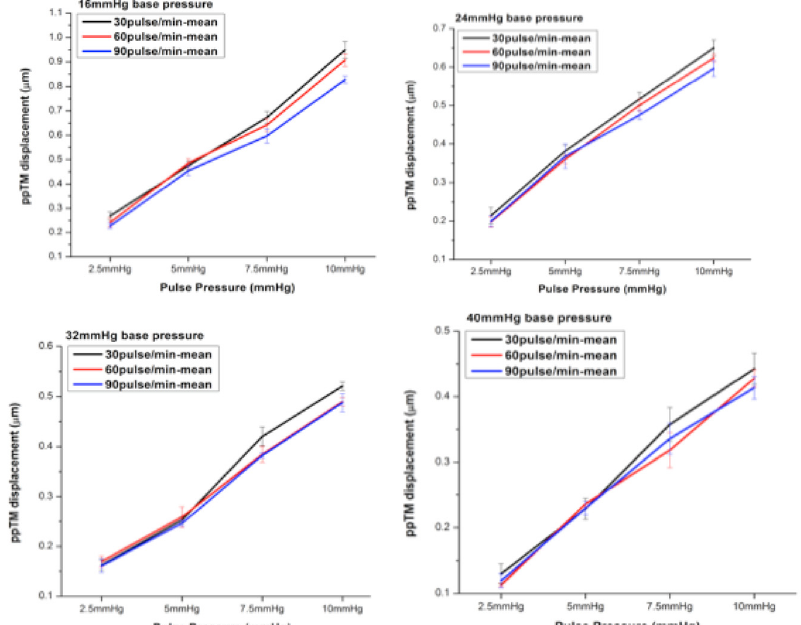
Figure 4. The mean and standard deviation of the peak-to-peak trabecular meshwork displacement (ppTMD) from applying various mean pressures, pulse amplitudes, and pulse frequencies. A different color specifies each pulse frequency, and each data point is the average of 4 measurements. Macaca Nemestrina Eye.